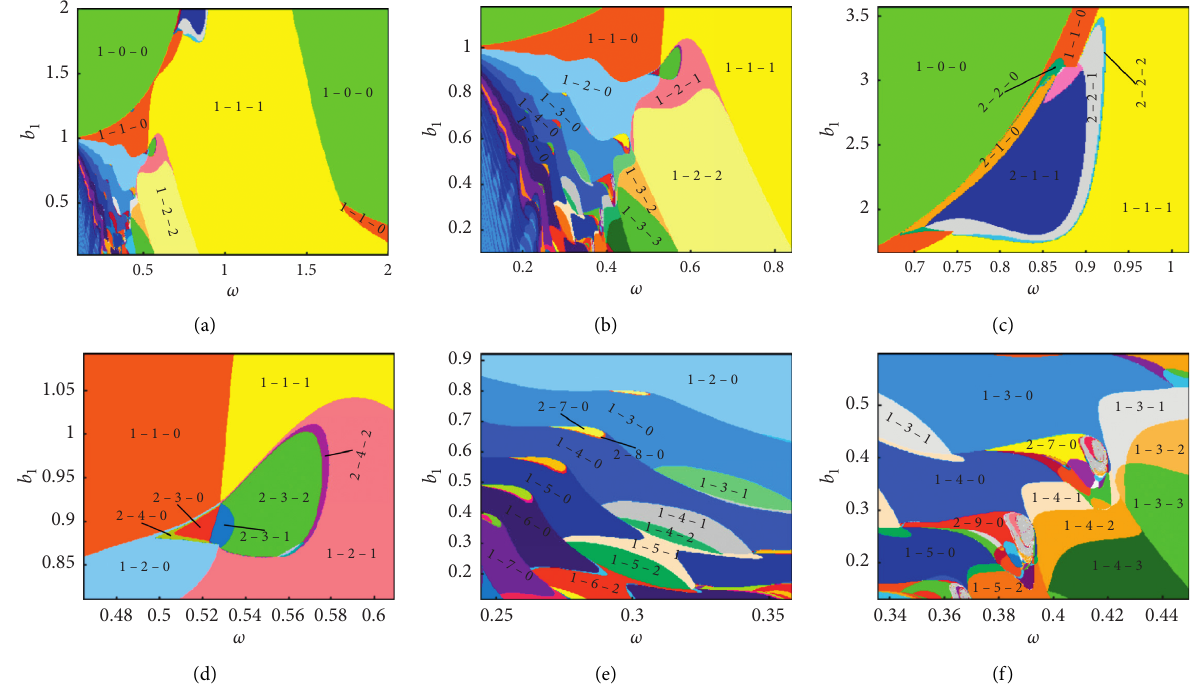
Figure 3: Distribution diagram of the periodic motion of the system in the parameter plane ( ω ,b views 1. (c) Transitional zone between 1 − 0 − 0 and 1 − 1 − 1 periodic motions. (d) Partial enlarged views 2 of Figure 3(a). (e) Partial enlarged views 3 of Figure 3(a). (f) Partial enlarged views 4 of Figure